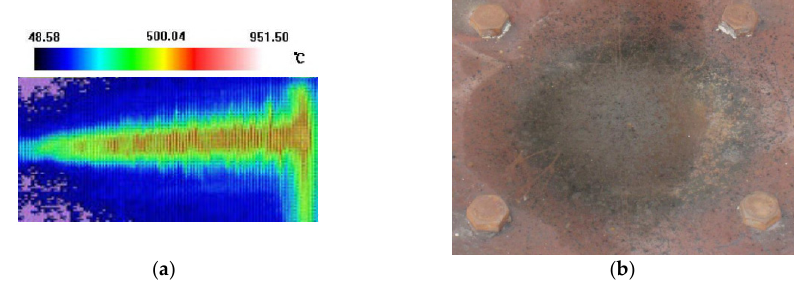
Figure 7. ( a ) IR (Infrared Radiation) image; ( b ) Picture of erosion region.